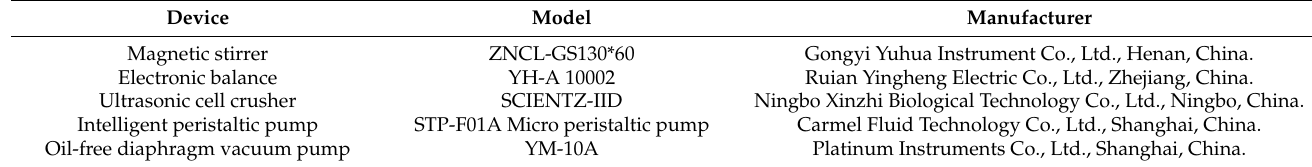
Table 2. List of experimental equipment